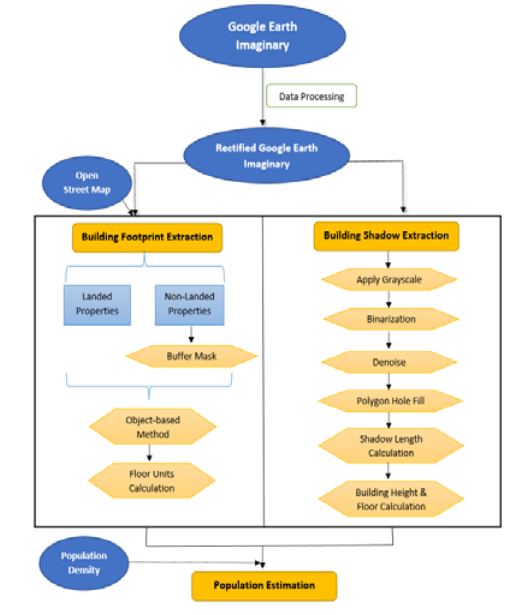
Figure 2. Workflow of the study